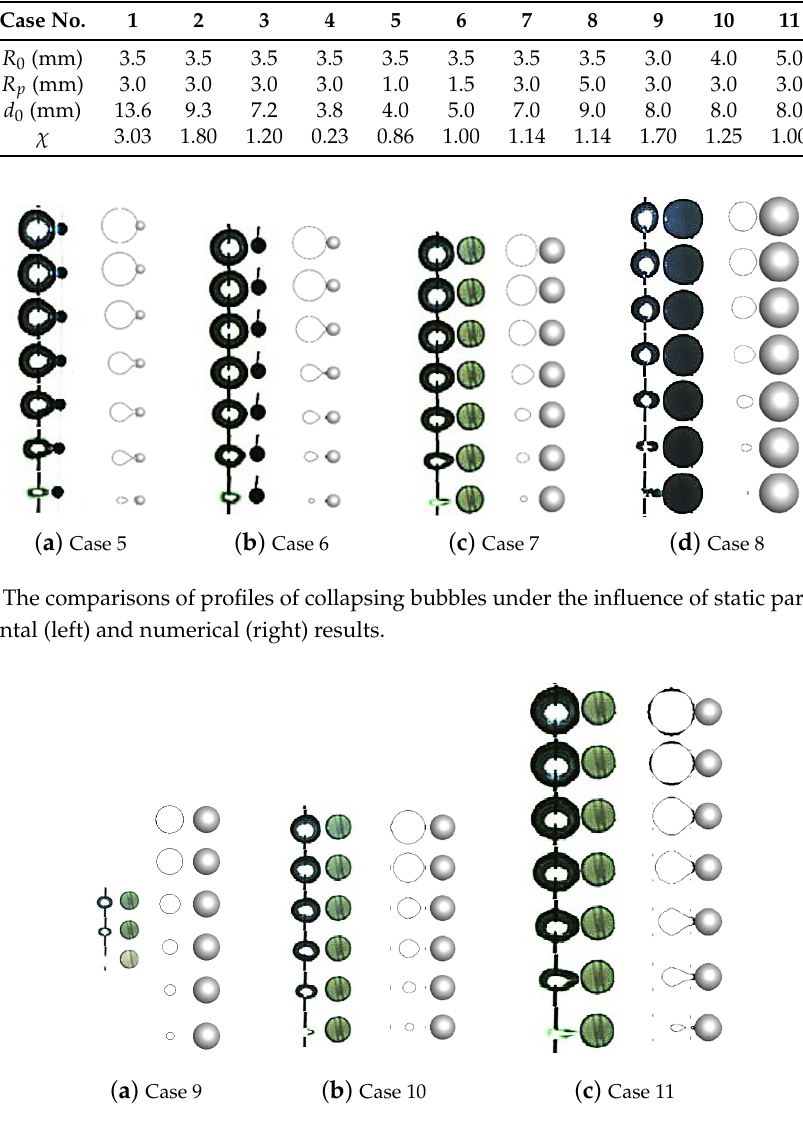
Figure 7. The comparisons of profiles of collapsing bubbles under the influence of static particles from experimental (left) and numerical (right)